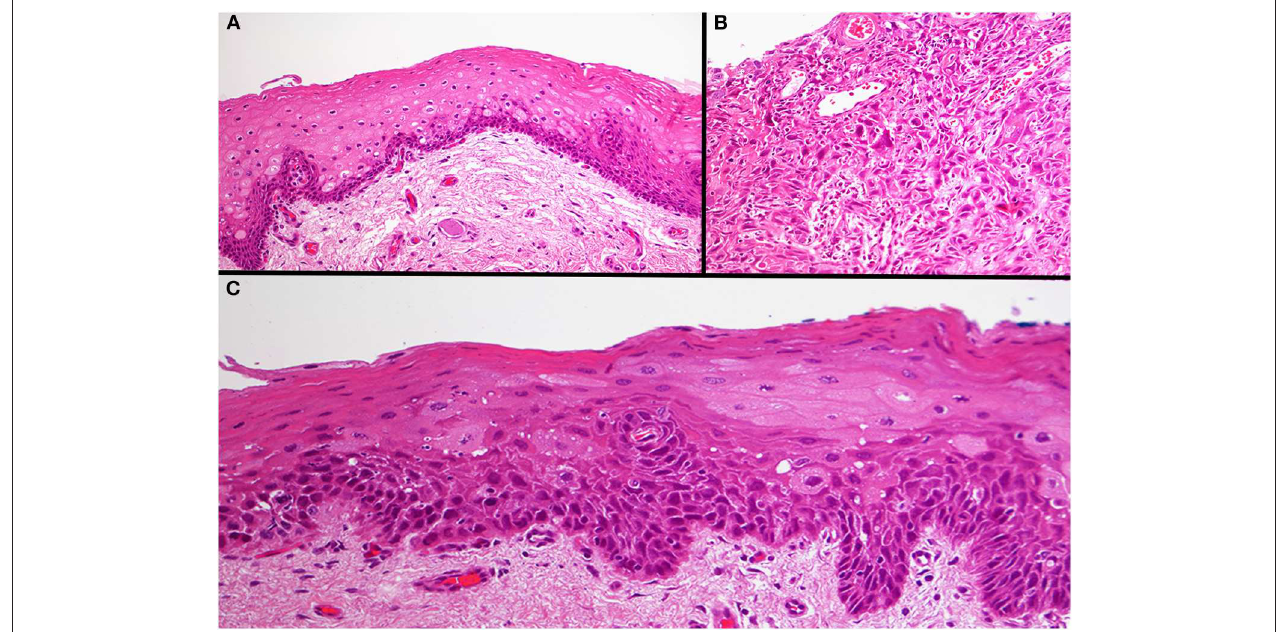
FIGURE 3 | Photomicrograph of the three different areas. Histology of the normal epithelium showing basal cell hyperplasia with no atypia (A) . The base of the tumor ulcer consisted of a poorly differentiated squamous cell carcinoma (B) . The tumor adjacent dysplastic epithelium (TADE) that showed loss of fluorescence with the VELscope ® showed the presence of moderate epithelial dysplasia (C) . Original magnification